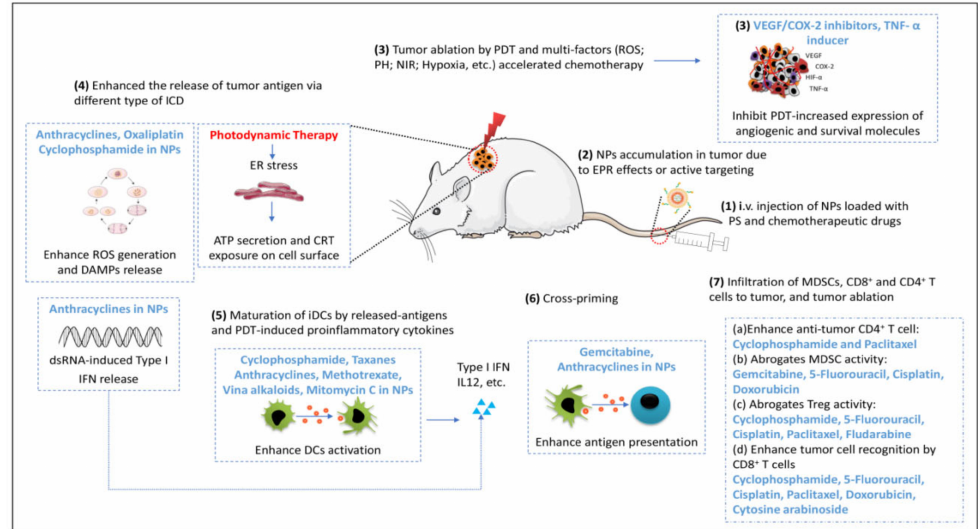
Figure 5. The mechanisms of NP-mediated chemo-photodynamic therapy enhance monotherapy in- dices and synergistically trigger robust antitumor immune responses for anti-primary and metastatic tumors: (1) intravenous injection of PSs and chemotherapeutic agents loaded with nanoparticles; (2) enhanced NP accumulation in tumor due to the tumor-targeting capability of NPs (EPR effects and targeting motif modification on NP surface); (3) primary tumor ablation by enhanced PDT and chemotherapy. PDT-caused vasculature rupture induced surviving tumor cells to produce more protumor factors in the tumor microenvironment. Antiangiogenetic mediators, such as VEGF and COX-2 inhibitors, help PDT to achieve more powerful tumor destruction and a lower recurrence or metastasis rate, by blocking tumor angiogenetic activity molecules or their receptors; (4) PDT and chemotherapy (anthracyclines, cyclophosphamide, and oxaliplatin) of the primary tumor to induce higher ICD levels and the release of tumor-associated antigens. Anthracyclines also induce dsRNA release from dead tumor cells, which can activate tumor-specific CD8 + T cells by binding to Toll-like receptor-3 and inducing type I interferon production; (5) DC maturation and antigen presentation are enhanced by PDT-generated antigens, proinflammatory cytokines, and chemother- apeutic agents; (6) cross-priming in tumor lymph node; (7) Chemotherapeutic agents in NPs can improve PDT-induced immune responses by modulating the activity of immune cell subsets and by promoting tumor cell